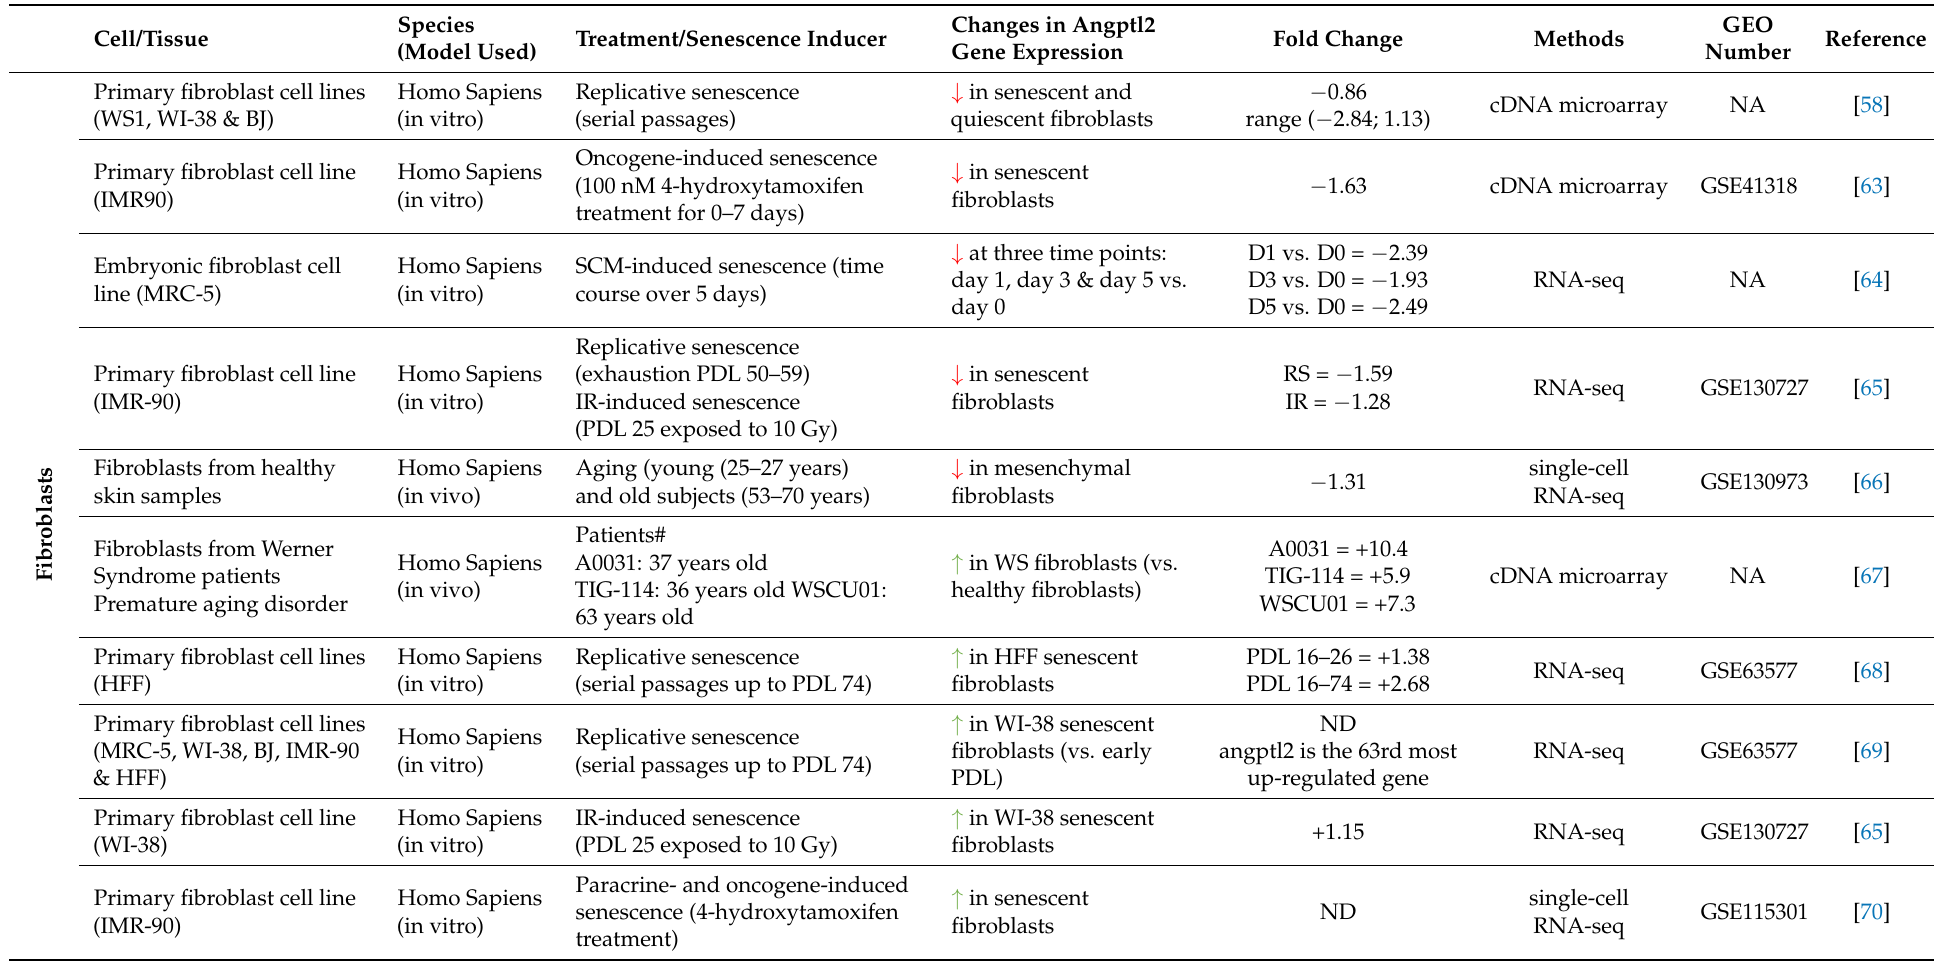
Table 1. Studies that identified angptl2 as a member of the